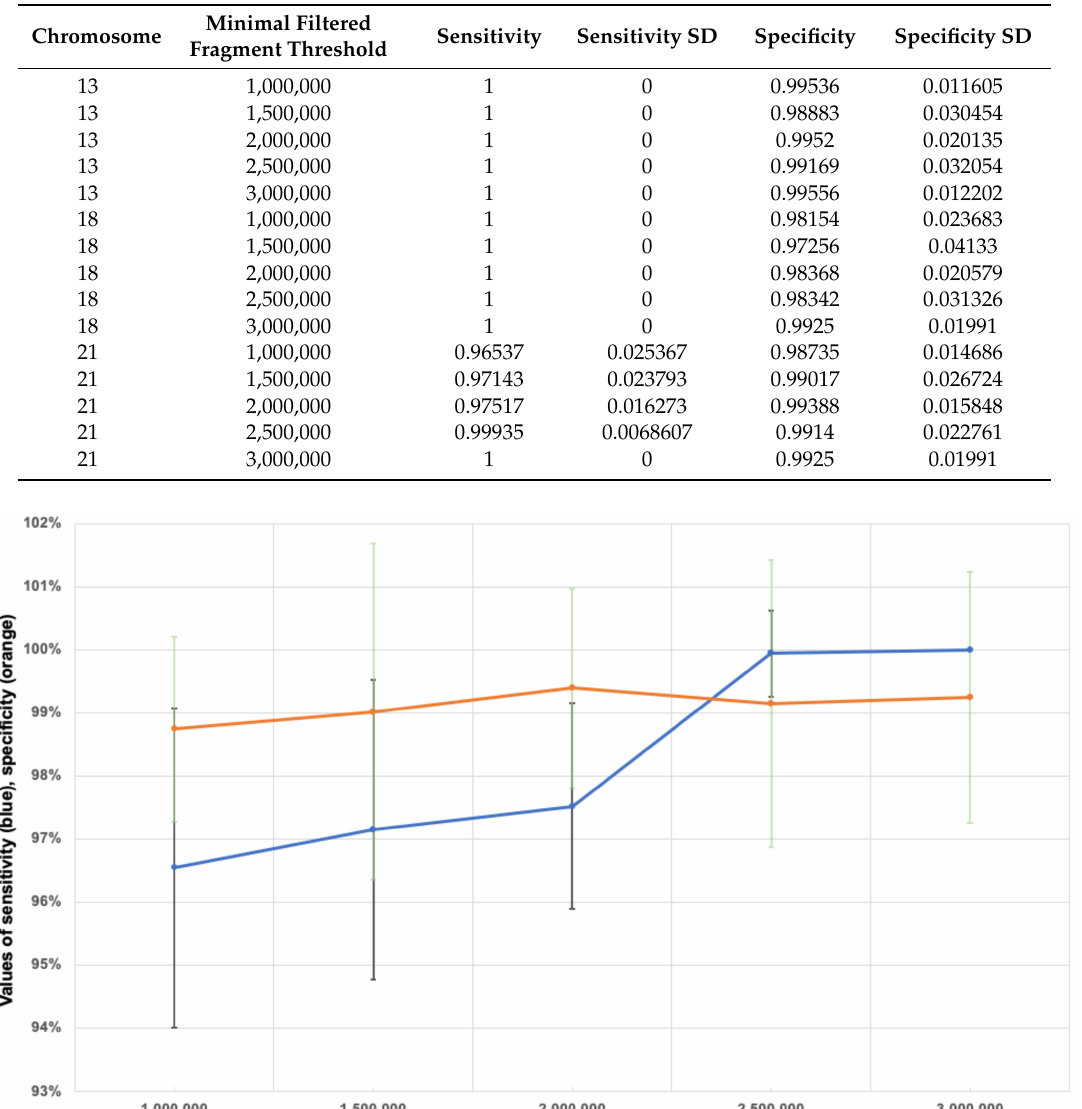
Table 2. Sensitivity and specificity calculation of the test for samples with the corresponding minimum number of unique fragments.